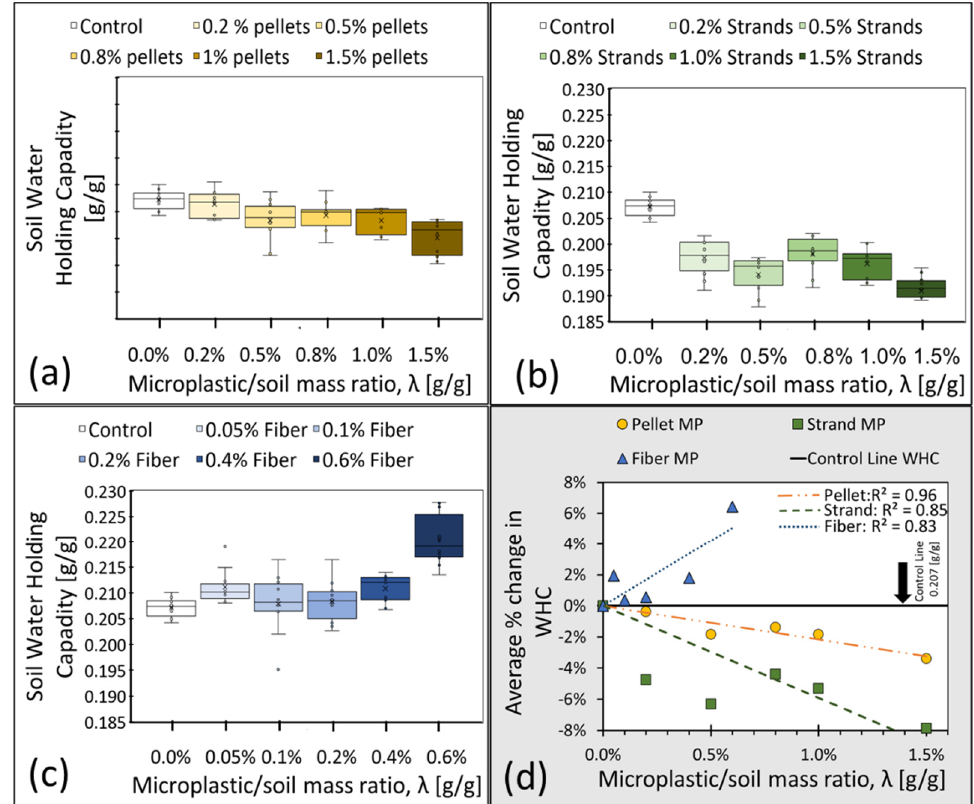
Figure 2. ( a – c ) depict the observed WHC as a function of λ (g/g) with standard Box and Whisker plots of WHC for samples contaminated by pellets, strands, and fibers, respectively. Each boxplot displays the median (middle line), mean (cross), first and third quartiles (lower and upper box lid), and collected data with dots. ( d ) shows through-the-origin linear regressions of the average values (N = 10 samples).